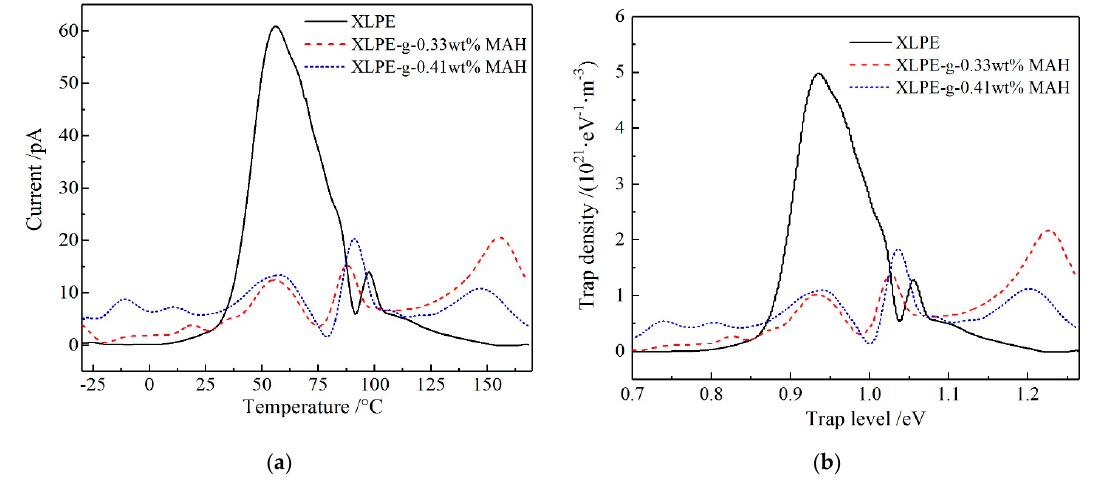
Figure 5. ( a ) TSC temperature spectra and ( b ) trap level distributions of XLPE and XLPE-g-MAH.